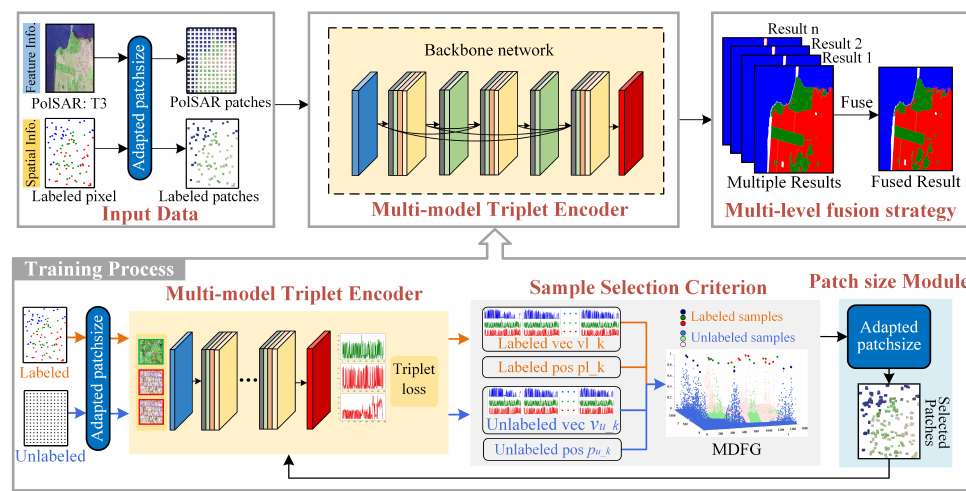
Figure 3. Architecture of the proposed multi-domain fusion graph